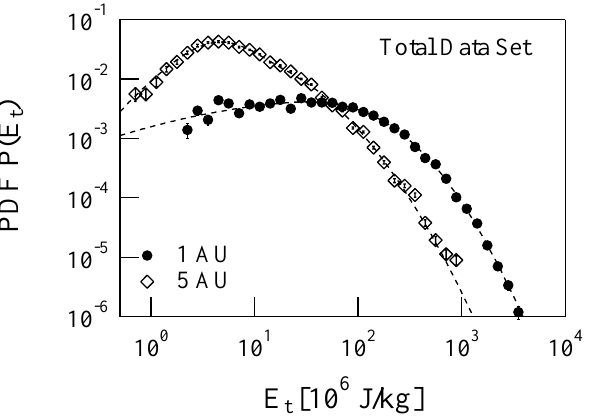
Fig. 4. The probability distribution functions P(E t ) of the total specific energy E t for the two distances. Dashed lines are empirical model fits using expression of Eq. (15).